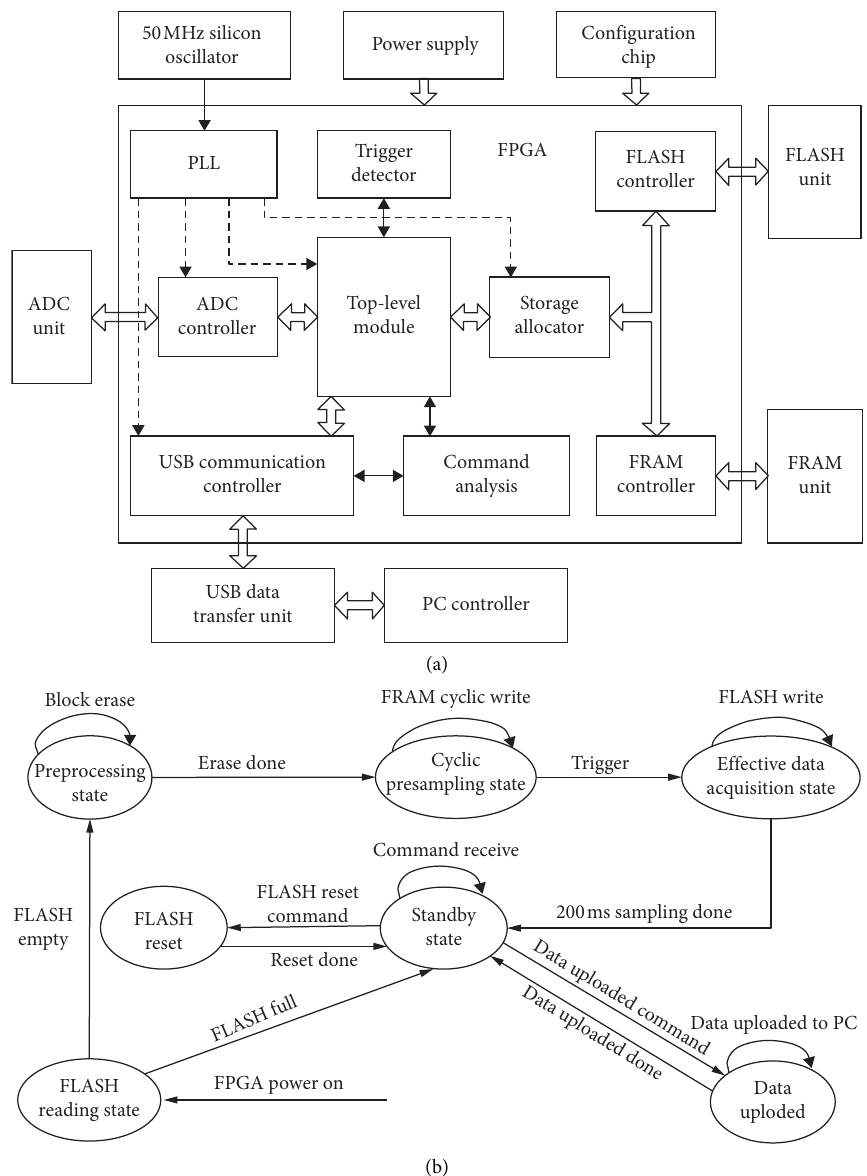
Figure 5: FPGA. (a) Block diagram of logic function. (b) State transition